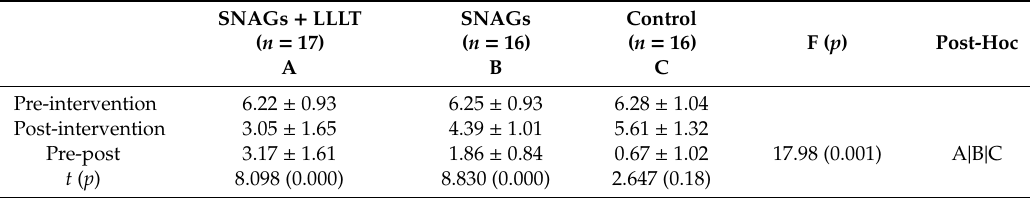
Table 2. Di ff erences in pain ( N =